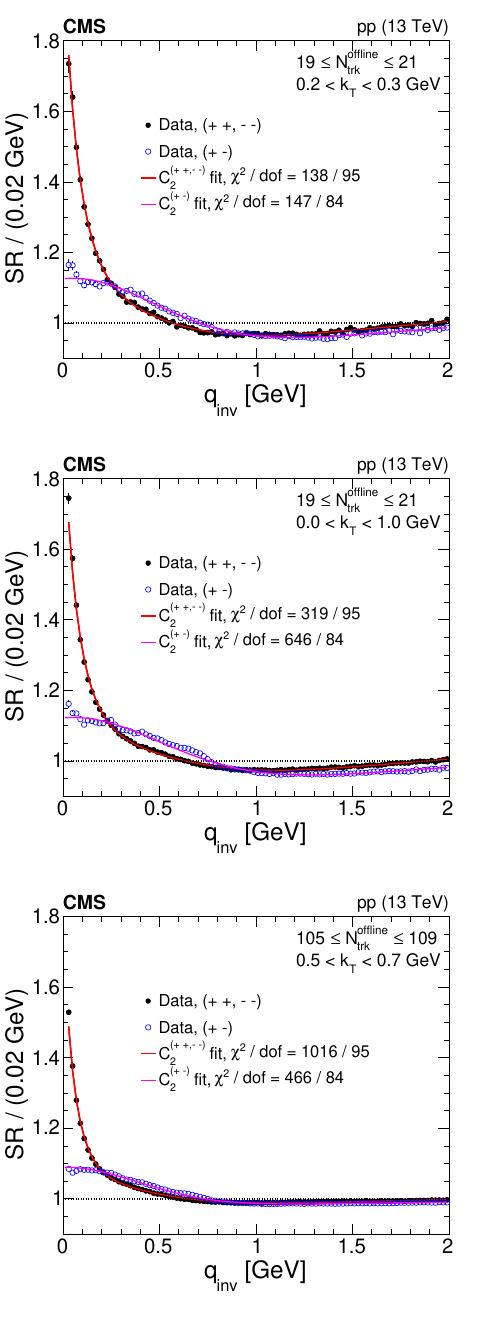
Figure 9 . The same-sign (++ ; (cid:0)(cid:0) ) and opposite-sign (+ (cid:0) ) single ratios are shown in di(cid:11)erent N o(cid:15)ine and k bins, together with the full (cid:12)ts (continuous curves) given in eqs. (A.2) and (A.5), for trk T minimum-bias (19 (cid:20) N o(cid:15)ine (cid:20) 21) and HM (105 (cid:20) N o(cid:15)ine (cid:20) 109) events. The error bars represent track track statistical uncertainties and in most cases are smaller than the marker size.